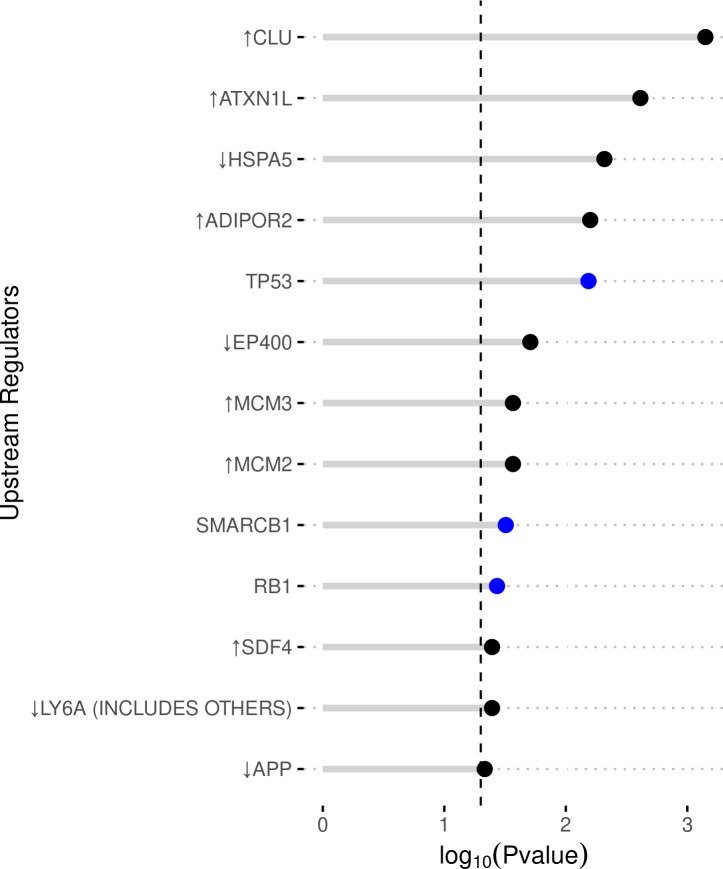
IPA upstream regulator analysis of DEGs.The enriched regulators are given on the y-axis. The x-axis represents the significance (negative Log of P-value). The color of the dots indicated level of significant z-score: black: |z|<1.96, red/activated: z>1.96, blue/inhibited: z<1.96. Arrows preceding the regulator name indicate the direction of differential expression from the cryopreservation group.